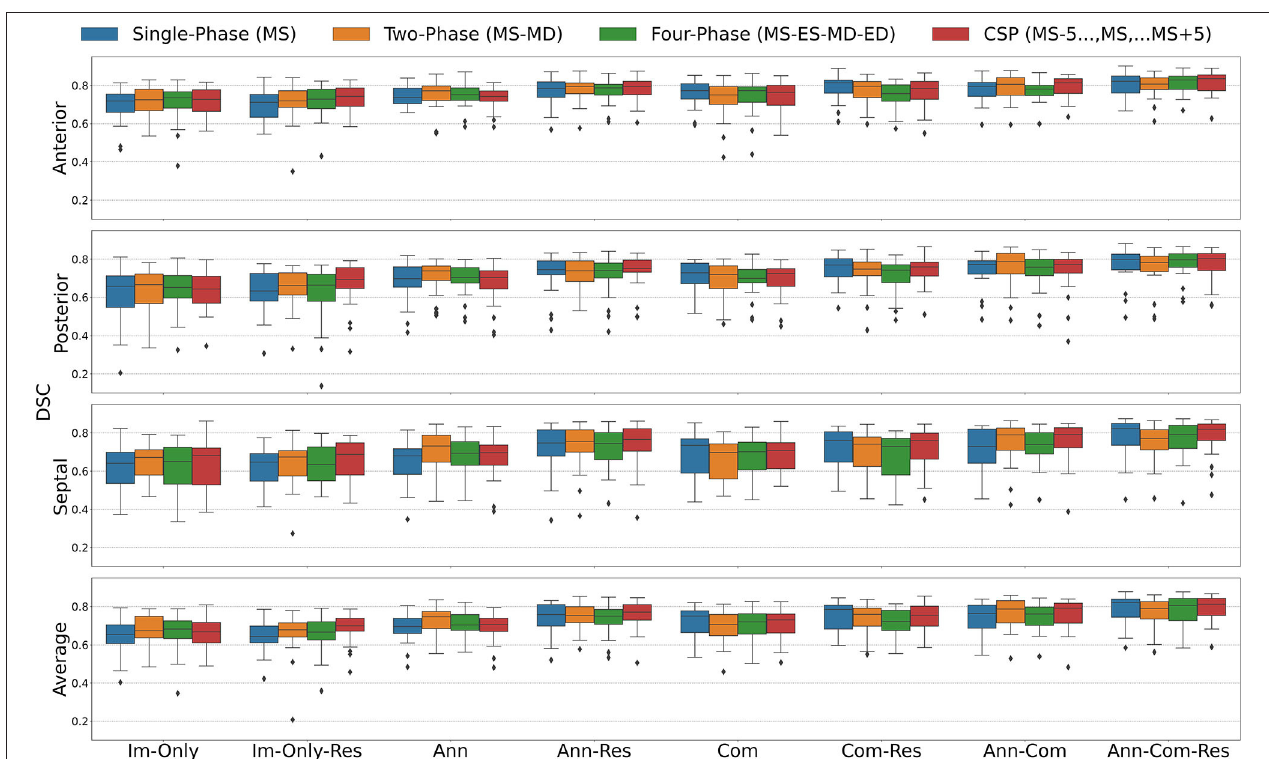
FIGURE 5 | Dice Similarity Coefficient (DSC) for all stages combined for all Input Frame Combinations (Single-Phase, Two-Phase, Four-Phase and CSP) and all Binary Combinations of the Annular Curve Input (Ann), Commissural Landmarks Input (Com) and Resampling (Res). FCN input configurations using more inputs performed better than those with fewer inputs. The number of 3DE input frames suggested a less clear pattern, where more input frames did not necessarily improve the FCN output segmentations. The number of input frames did not yield a large effect on the FCN segmentations compared to the introduction of other auxiliary FCN inputs and the inclusion of resampling. Segmentation accuracy is presented for individual leaflets (anterior, posterior, septal) and the individual leaflet average. The boxes represent median DSC with IQR. The whiskers present 1.5*IQR past the low and high quartiles. The diamonds indicate